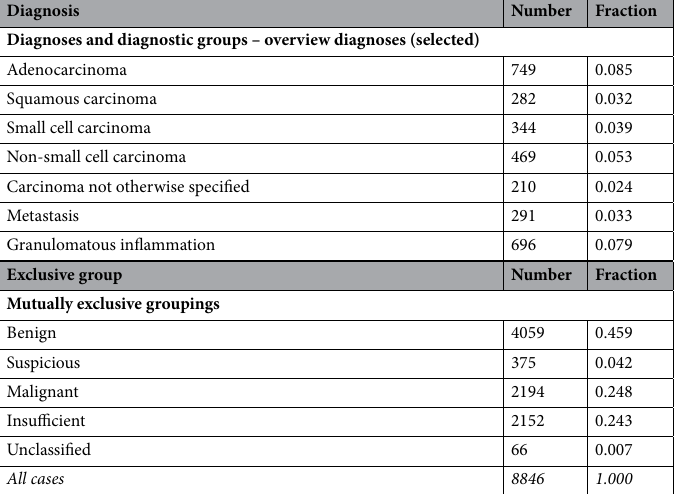
Diagnosis Number